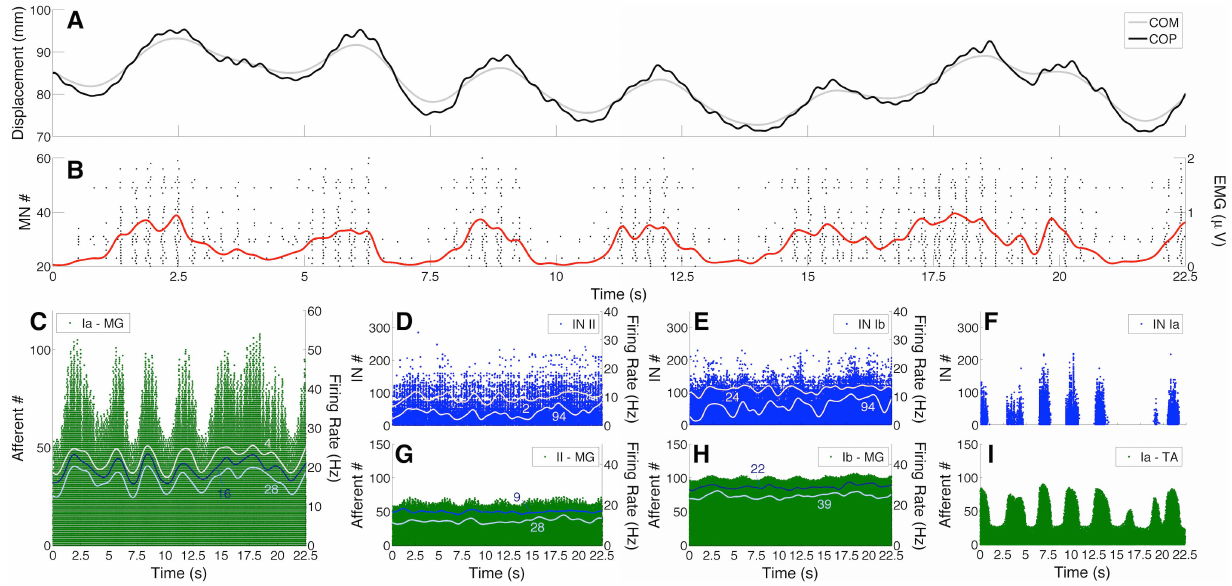
Figure 4. Intermittent recruitment of Medial Gastrocnemius (MG) motor units (MUs) and modulation of proprioceptive feedback (typical simulation performed on Model2 ). (A) Centre of mass (COM; gray curve) and centre of pressure (COP; black curve) displacements. (B) Raster plots (black dots) of * 40 MG MUs intermittently recruited during quiet standing. Red curve represents the global MG electromyogram (EMG) envelope. Note the ballistic-like (phasic) activation of this muscle during postural sway. (C) Raster plots for the population of Ia afferents from the MG muscle. Note the clear modulation in the recruitment of primary afferents. In addition, continuous curves show the instantaneous firing rate (estimated by a Gaussian kernel convolved with the spike trains) for three Ia afferents (4, 16, 28). (D-F) Raster plots for group II excitatory interneurons (INs), Ib inhibitory INs, and Ia inhibitory INs. Continuous curves in panels D and E represent the instantaneous firing rate for two type-specified INs (2 and 94 for group II INs; 24 and 94 for Ib INs). (G-I) Raster plots for type II afferents from MG muscle spindle, Ib afferents from MG muscle spindle, and Ia afferents from TA muscle spindle. Continuous curves in panels G and H represent the instantaneous firing rate of two type-specified afferent fibres (9 and 28 for type-II afferents; 22 and 39 for Ib afferents).